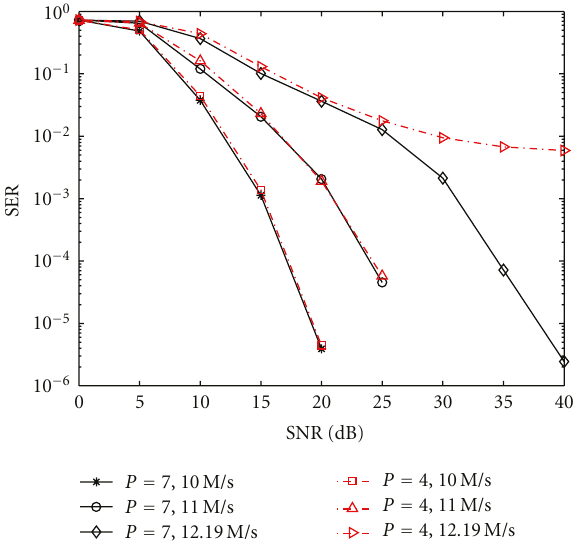
Figure 8: SER performance comparison for di ff erent oversam- pling factors P , with CFOs randomly chosen within the range [0,0 . 001 /T s ].